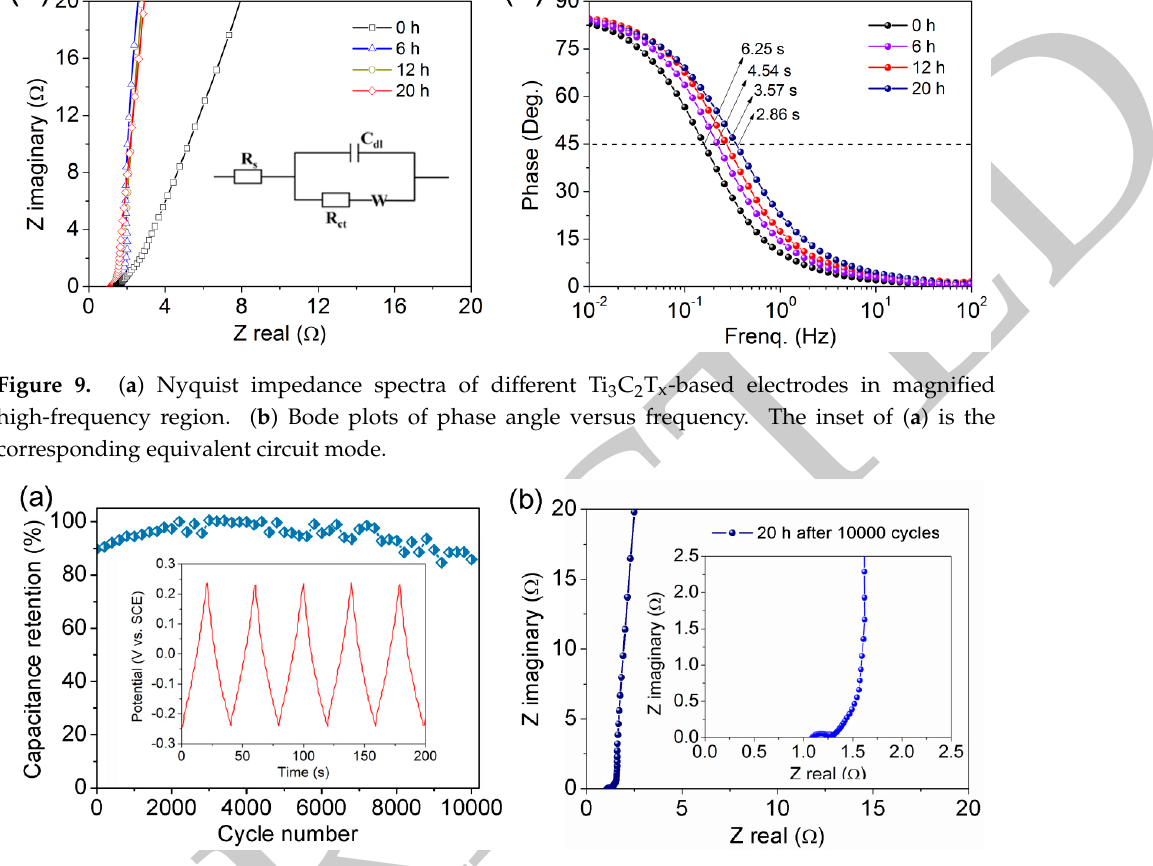
Figure 10. ( a ) Life cycle test in 1 M H 2 SO 4 up to 10,000 cycles at the charge/discharge rate of 8 A g − 1 . ( b ) Nyquist spectrum of 20 h N-TiO 2 /TiN/Ti 3 C 2 T x after 10,000 cycles. The insets are ( a ) the last five GCD cycling data at a current density of 8 A g − 1 and ( b ) the magnified high-frequency region.